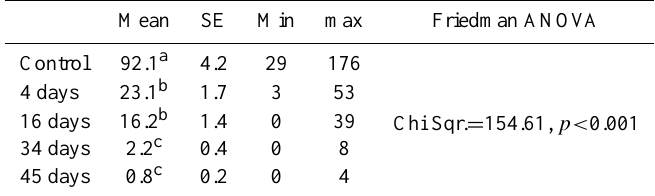
Table 2. Summary of Friedman ANOVA and Tukey HSD test, for ash thickness in slope area in all measurement periods. Different letters mean significant differences at a p< 0 . 05. Data in mm. ( a = higher mean, c = lower mean ).